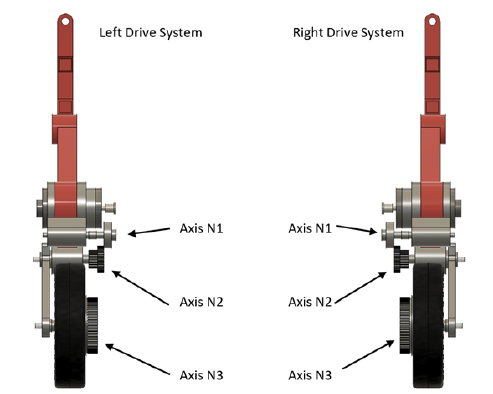
Figure 14. Left and Drive Systems .